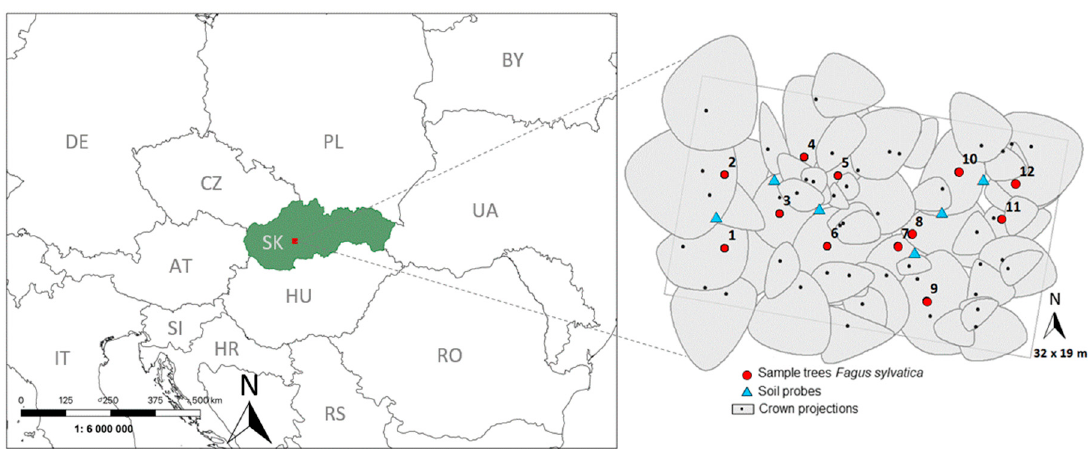
Figure 1. Location of the experimental plot Bienska dolina in central Slovakia (SK), Central Europe ( left ) and design of the experimental plot showing crown projections of all beech trees, position of selected sample trees and soil probes ( right ).